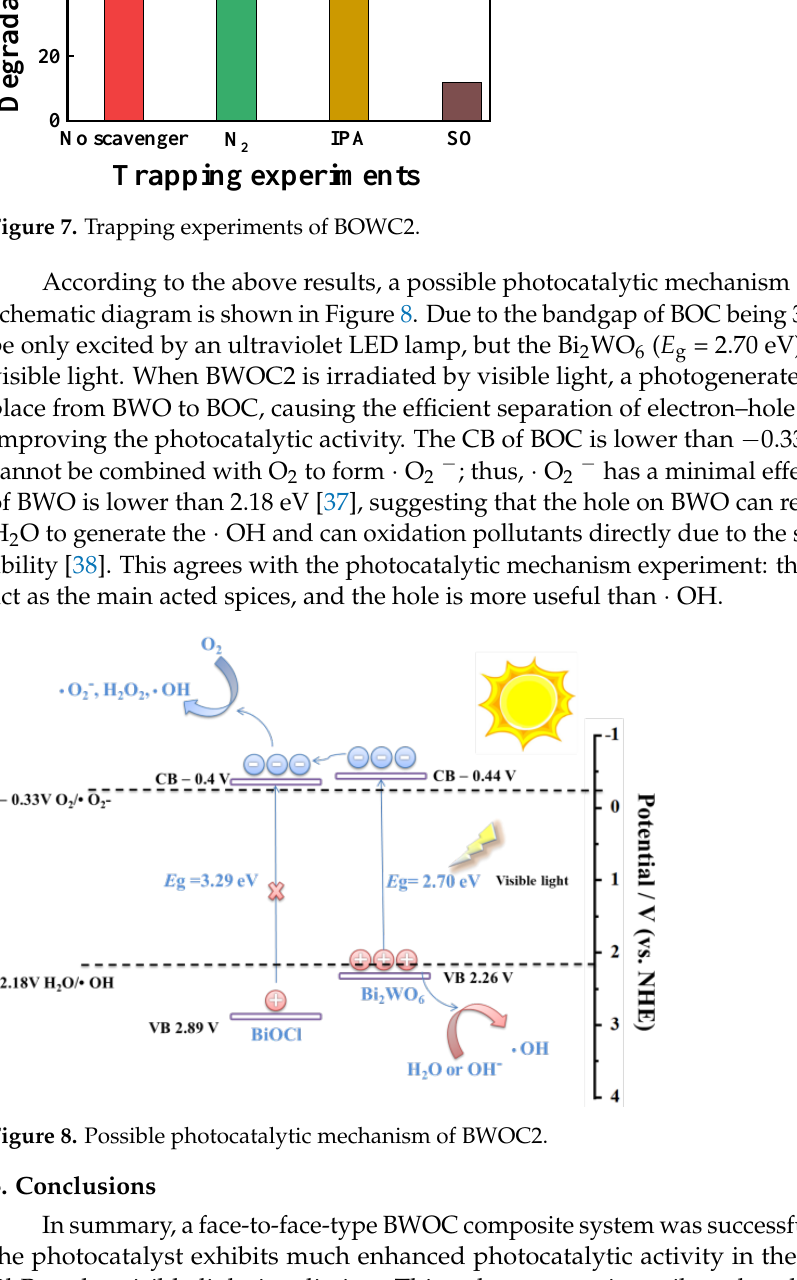
Figure 8. Possible photocatalytic mechanism of BWOC2.